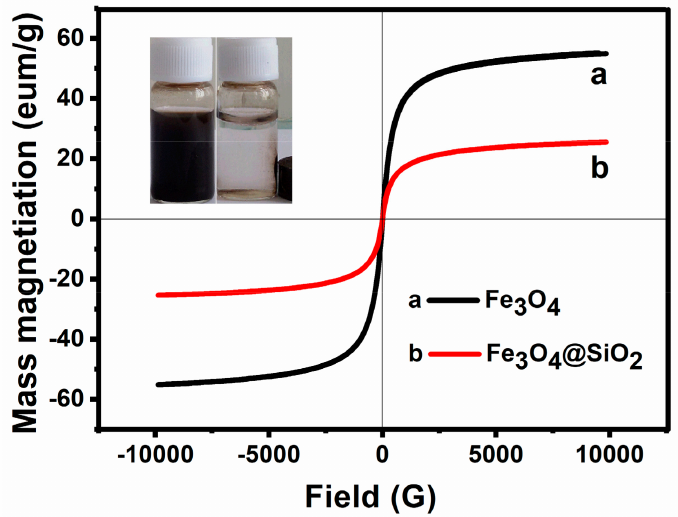
Figure 5. VSM characterization of Fe 3 O 4 MNPs and Fe 3 O 4 /SiO 2